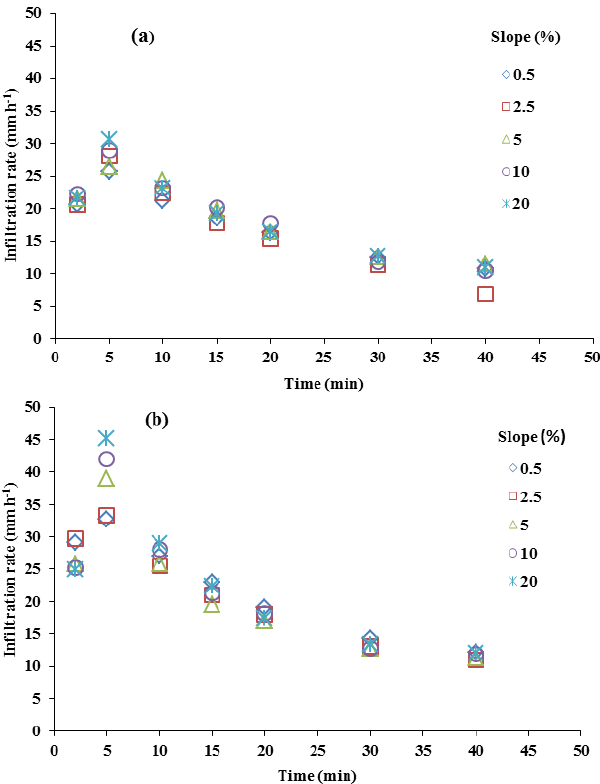
Figure 7. Comparison of the unsteady infiltration rate for soil sam- ples with the maximum particles size of (a) 2 and (b) 4.75mm (error bars represent standard errors of the means and mean comparison using Duncan’s test; α = 0 .